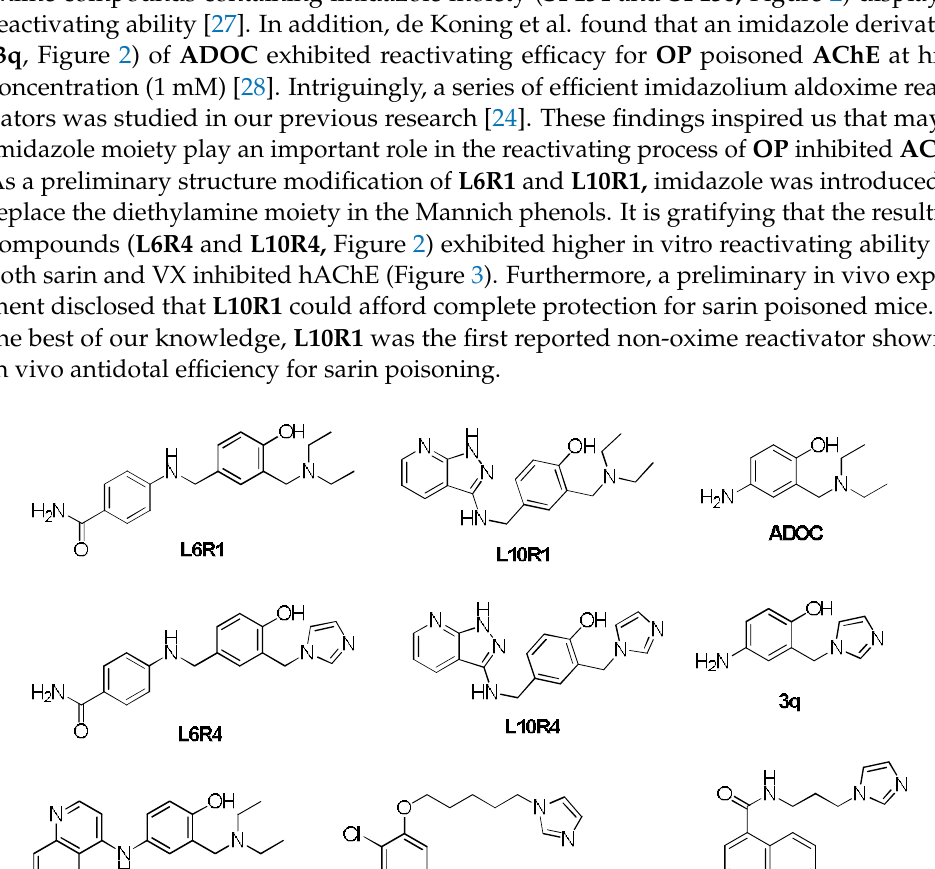
Figure 3. % Reactivation of non-oxime reactivators for VX and sarin inhibited hAChE. 2. Results and Discussion 2.1. Synthesis The synthetic routes to prepare these novel non-oxime compounds were outlined in Scheme 1. Firstly,